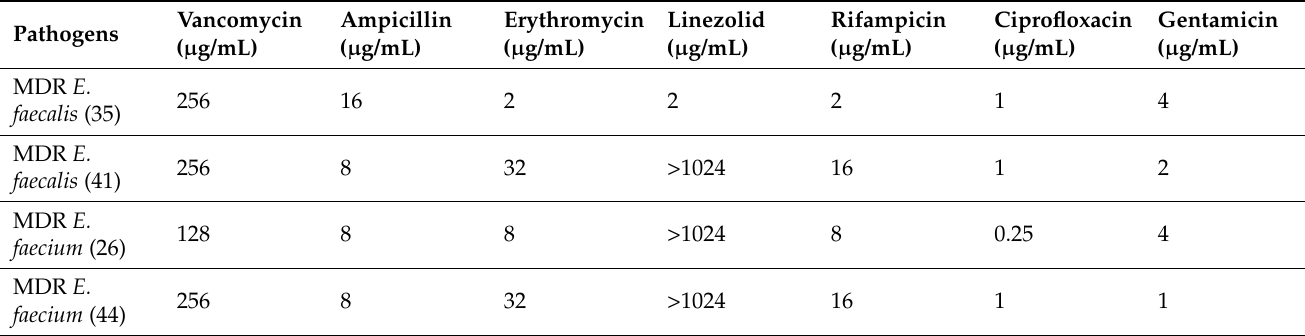
Table 2. Minimum Inhibitory Concentration of the studied